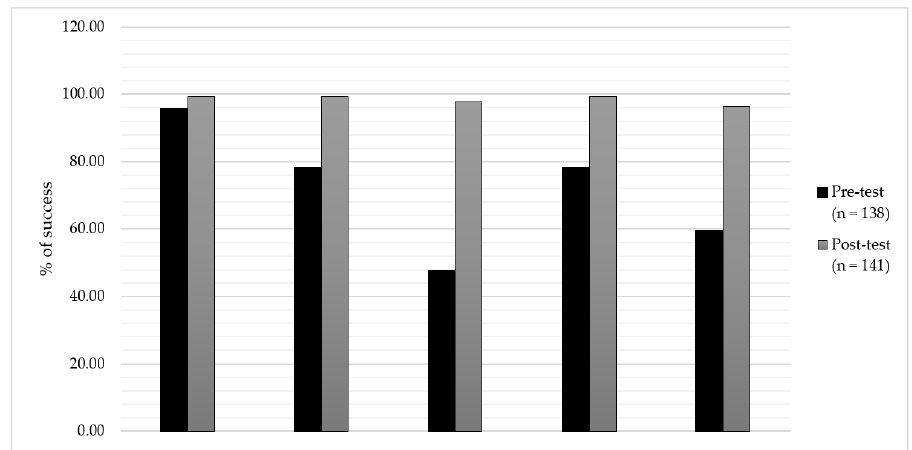
Figure 1. Evaluation of changes in areas before and after the intervention. PC, Palliative